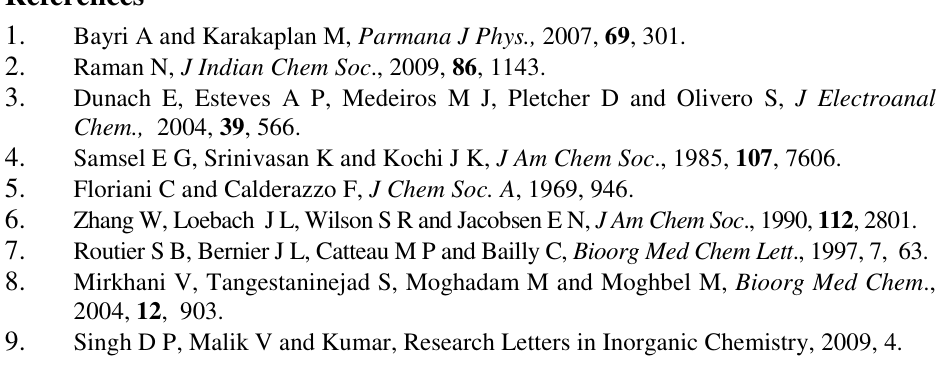
Bacterial inhibition, %